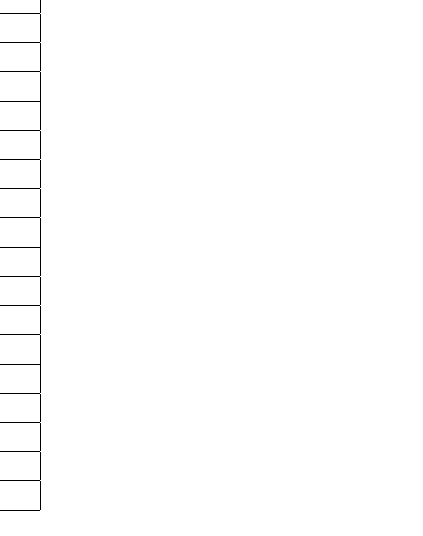
Table 2. % Stutter in 19 loci from 357